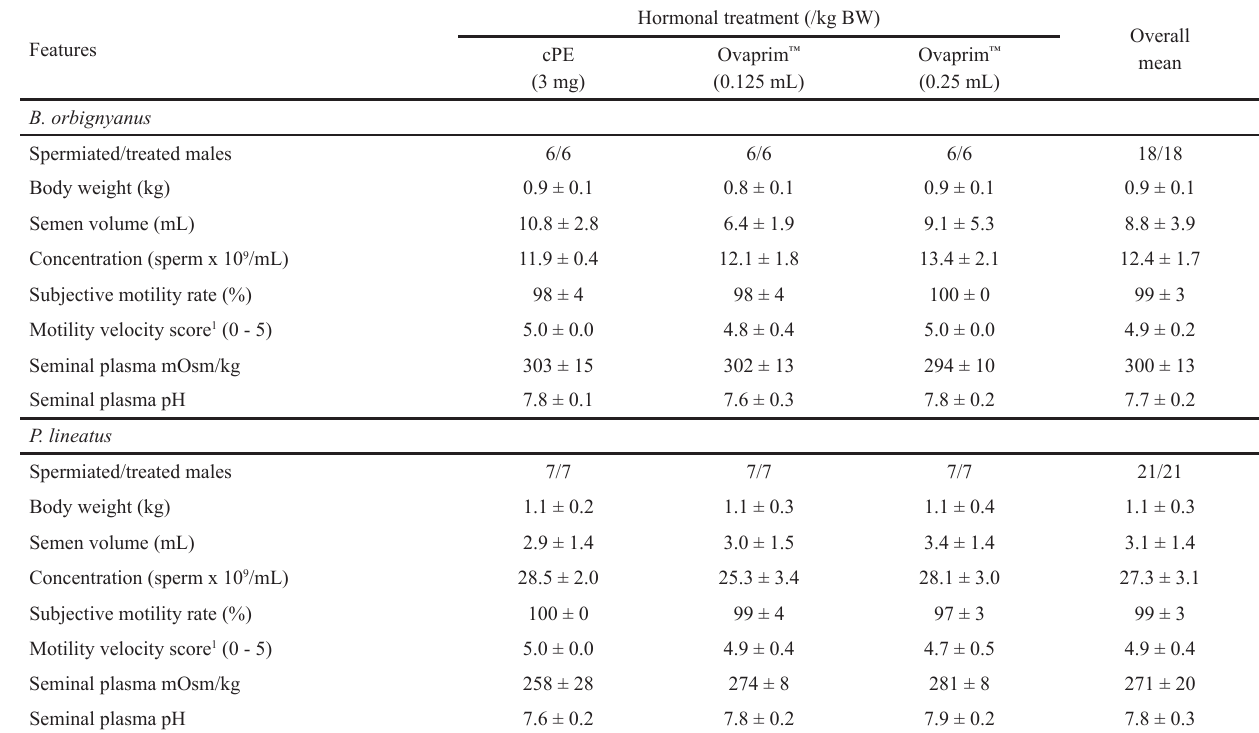
Table 1. Male body weight and fresh sperm quality (mean ± SD) of Brycon orbignyanus and Prochilodus lineatus males after treatment with a single dose of carp pituitary extract (cPE) or Ovaprim ™ .